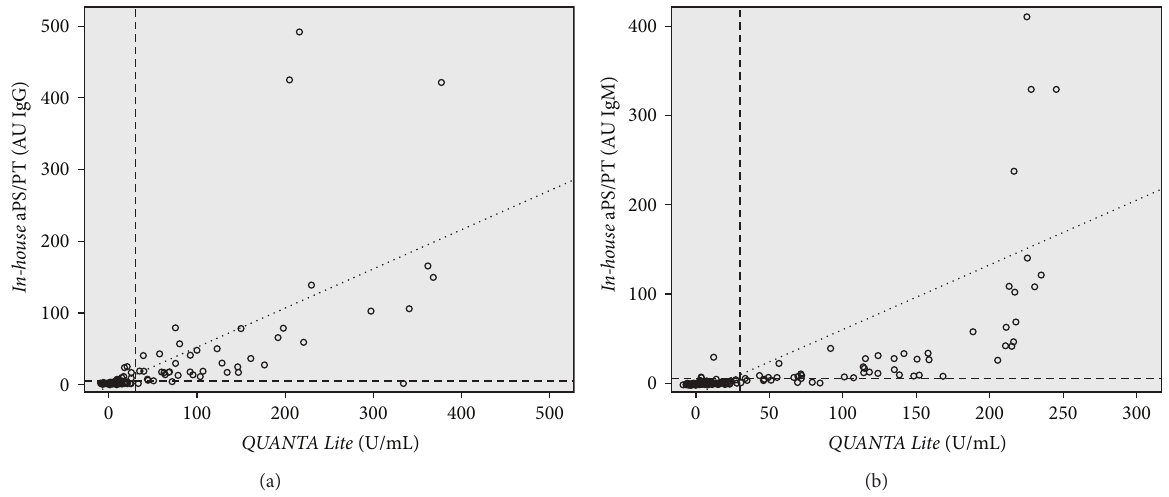
Figure 1: aPS/PT antibodies detected with the in-house ELISA correlated significantly with results of QUANTA Lite IgG (a) and IgM (b) in 156 patient sera. The dashed lines represent the cut-off value ( in-house ELISA 5 AU, QUANTA Lite 30U/mL). AU: arbitrary